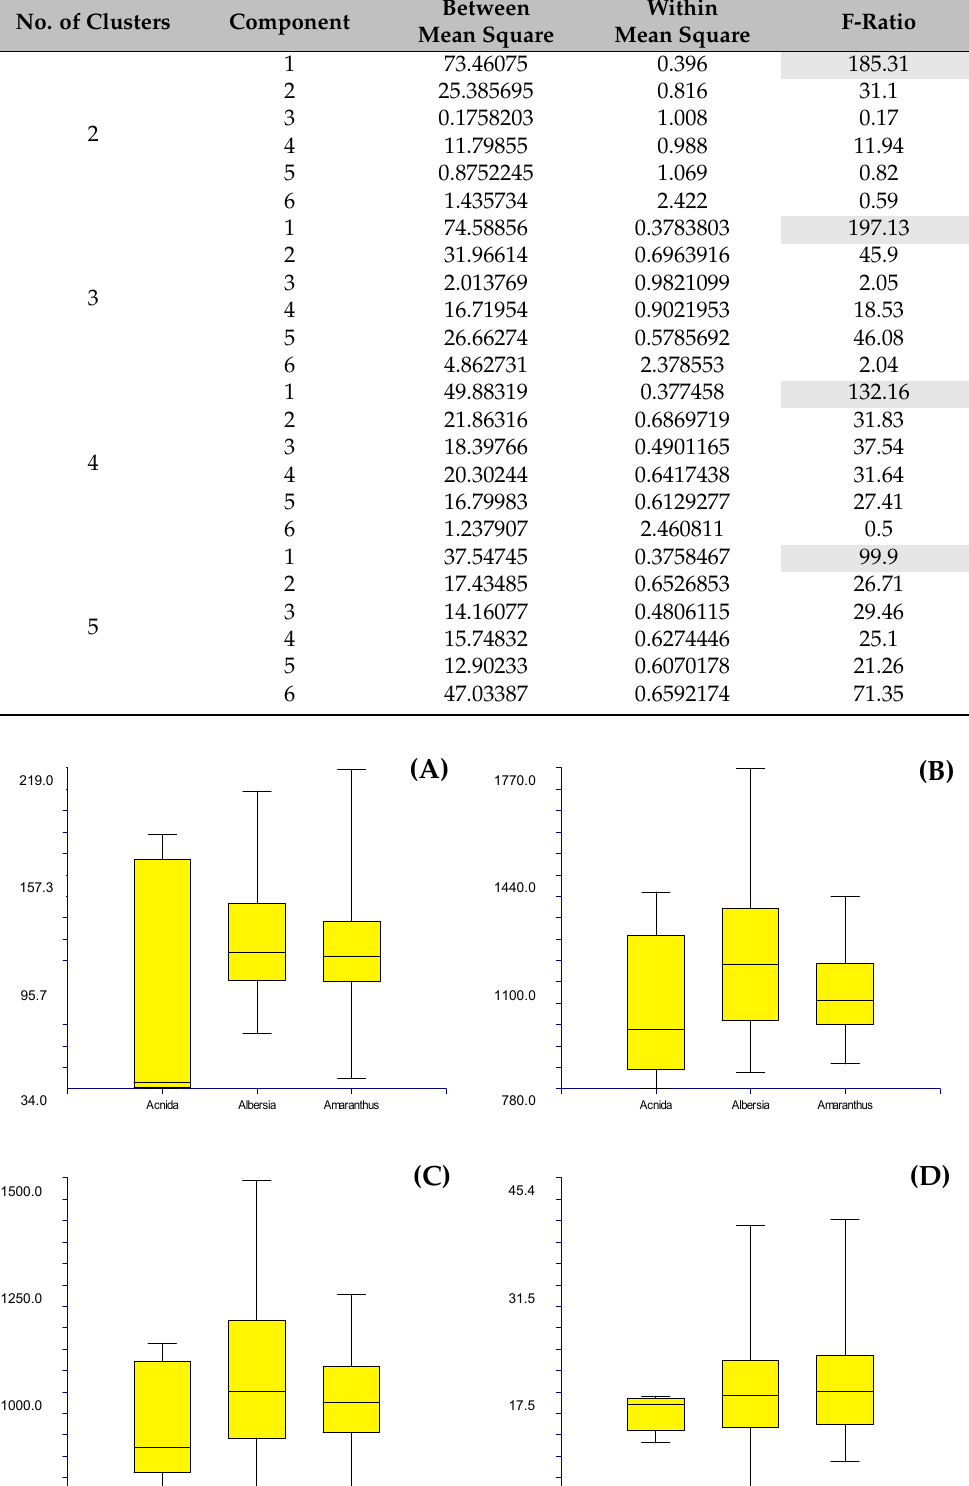
Table 4. K-means procedure performed on 2, 3, 4, and 5 clusters.